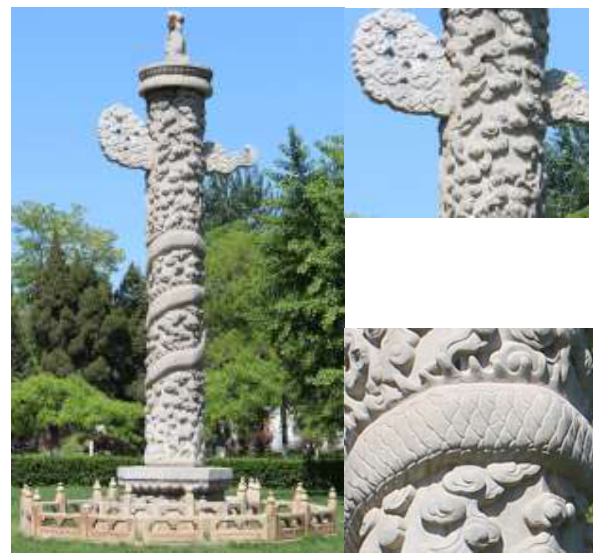
Figure 1. Photo of